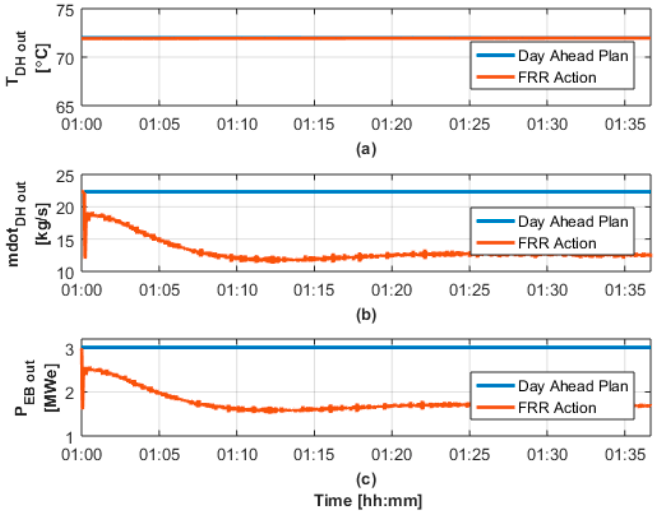
Figure 18. EB’s main variables during FRR action: ( a ) temperature of forwarded water into DH network; ( b ) hot water’s mass-flow to DH network and ( c ) electrical power consumption of EB.